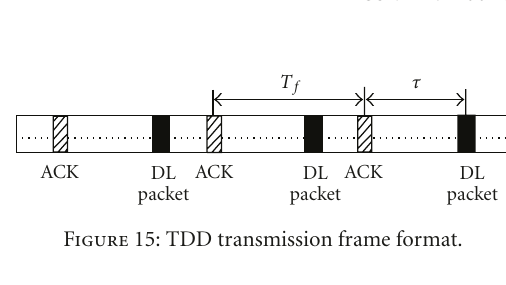
Figure 14: Block diagram of a MIMO E-SDM system.